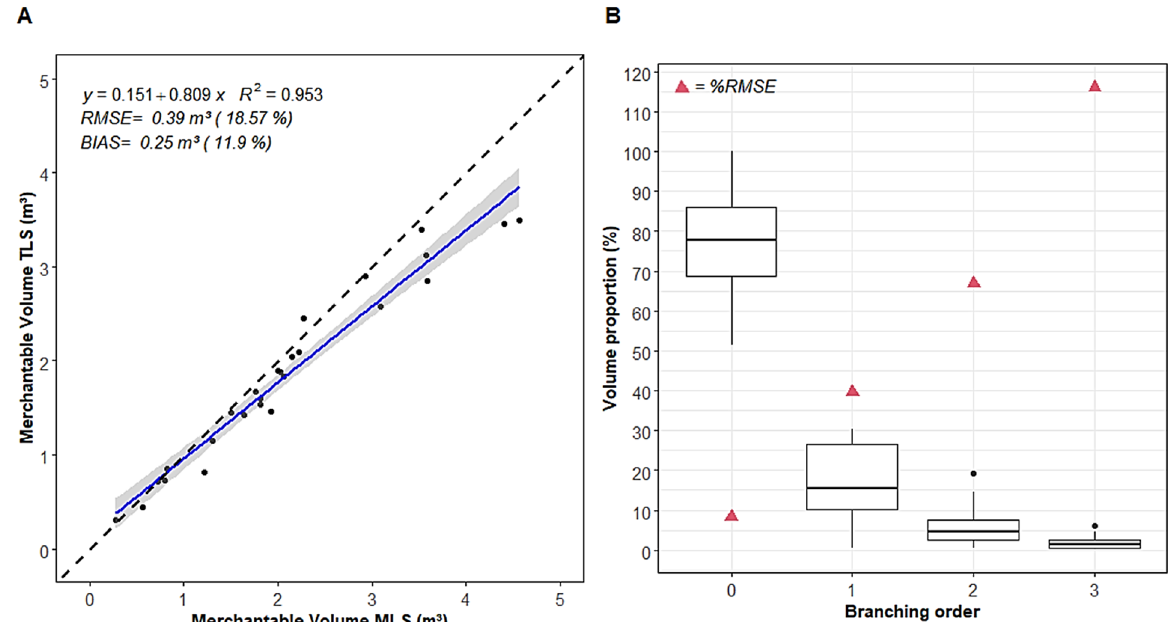
Figure 11. ( A ) Comparison of total merchantable volume (i.e., stem and branches with small end diameter outside bark (DOB) ≥ 8 cm) derived from TLS and MLS QSMs (i.e., branching order 0–3 with small end DOB ≥ 8 cm). n = 26 trees. The blue line represents the linear regression. The grey zone is the 95% confidence band for predictions. The dashed black line represents the 1:1 line. ( B ) Boxplots of the proportion of merchantable volume by branching order (0 = main stem; 1 = first ‐ level branches; 2 = second ‐ level branches; 3 = third ‐ level branches) from TLS QSMs. Red triangles represent the %RMSE by branching order.